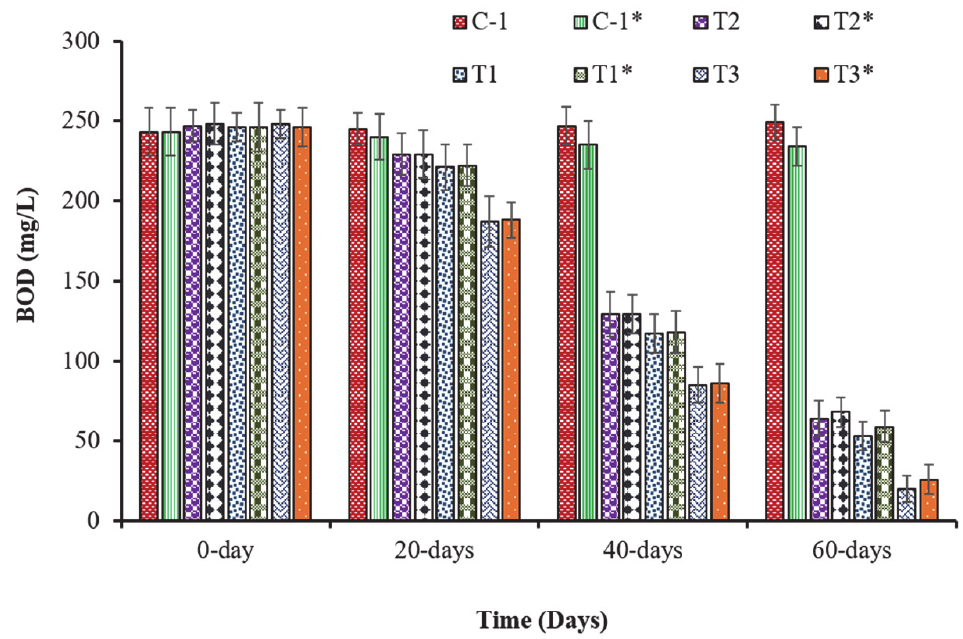
Figure 6. BOD reduction in CWs and FTWs vegetated with Phragmites australis.